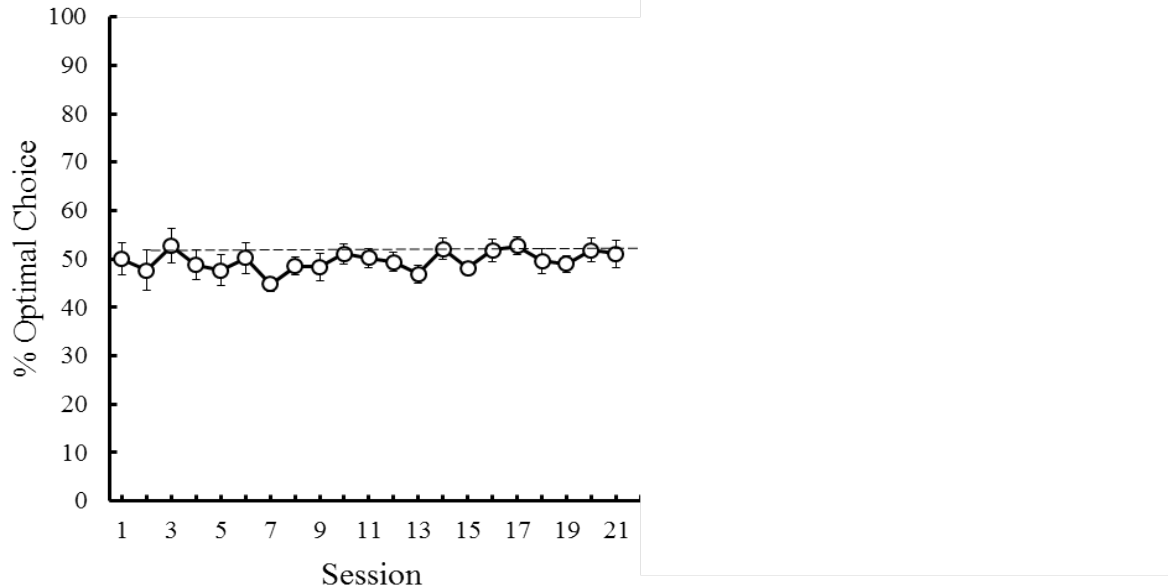
Figure 5 . Rats’ performance on the automated ephemeral reward task (error bars = ±SEM; after Zentall et al., 2017b, Exp.